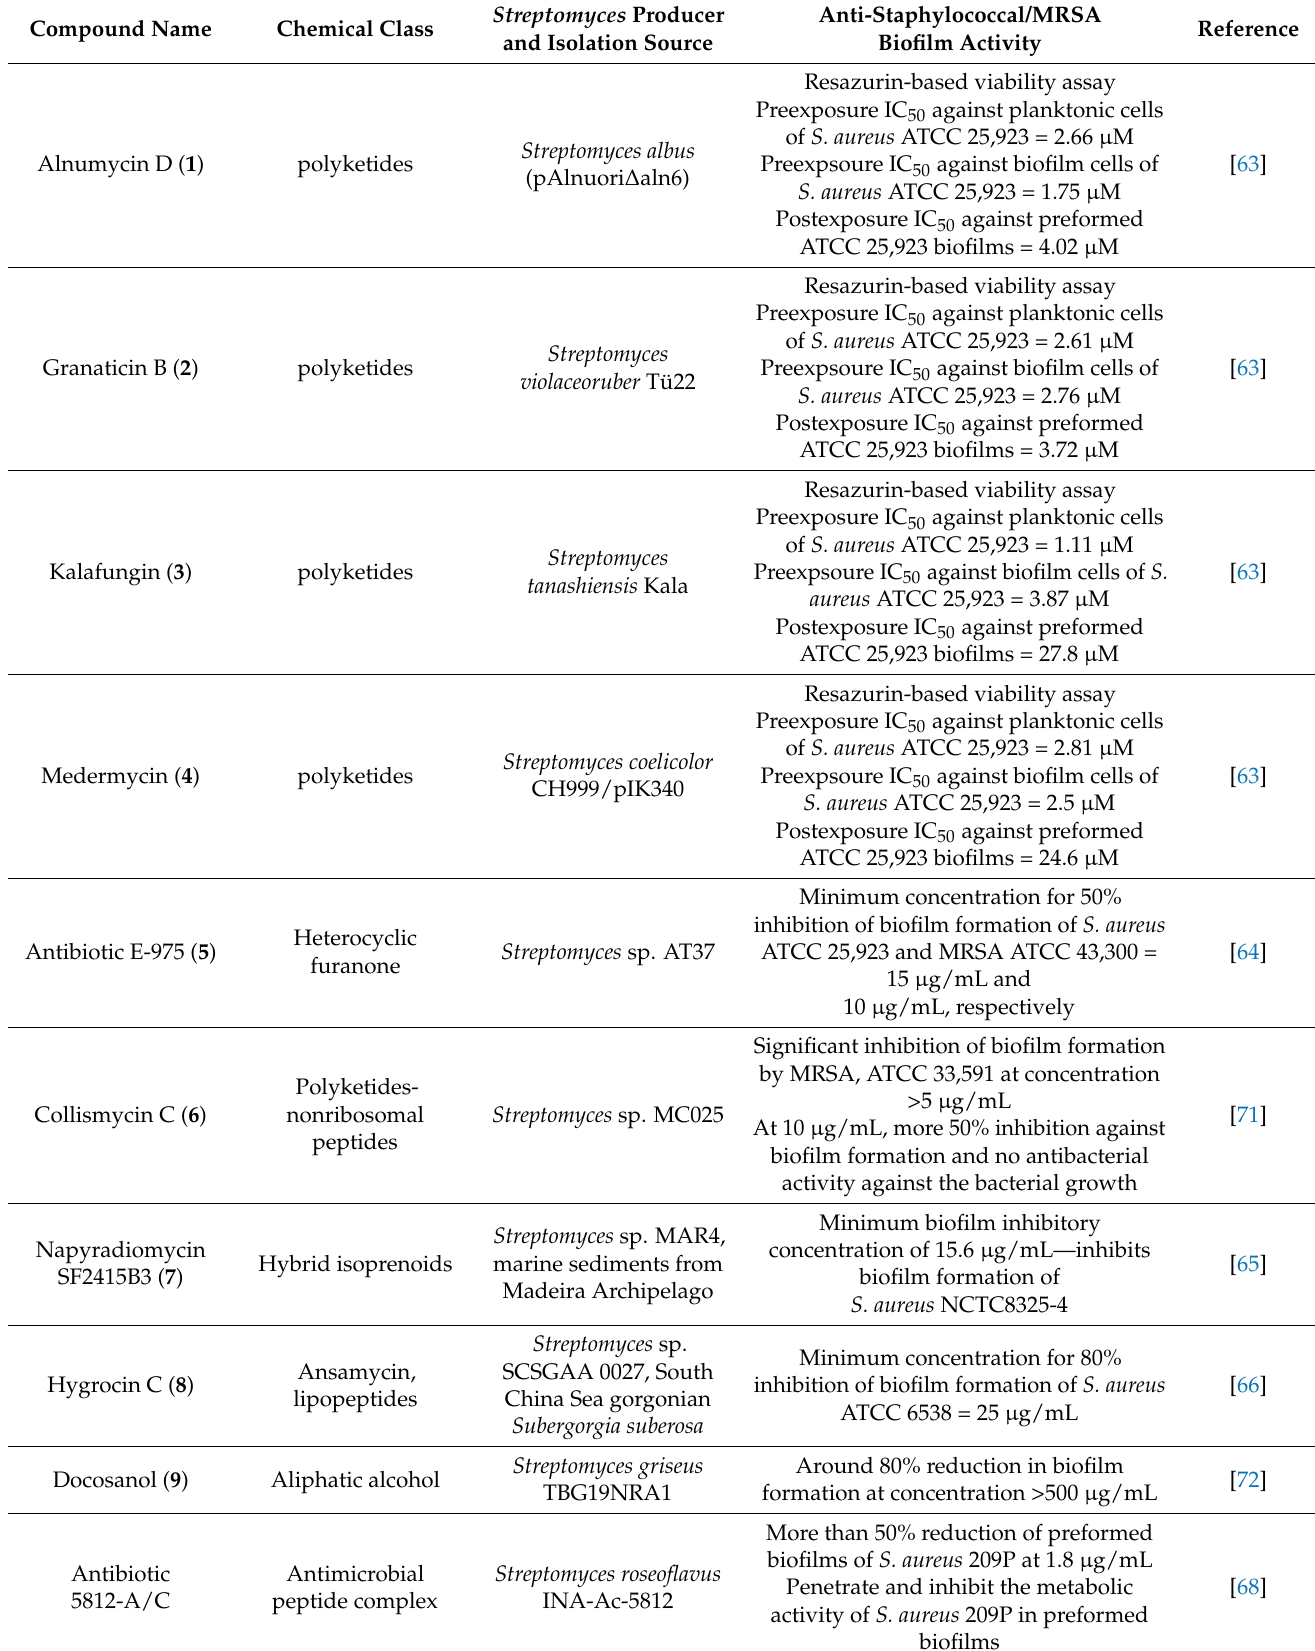
Table 1. Potential anti-staphylococcal/MRSA biofilm agents derived from Streptomyces